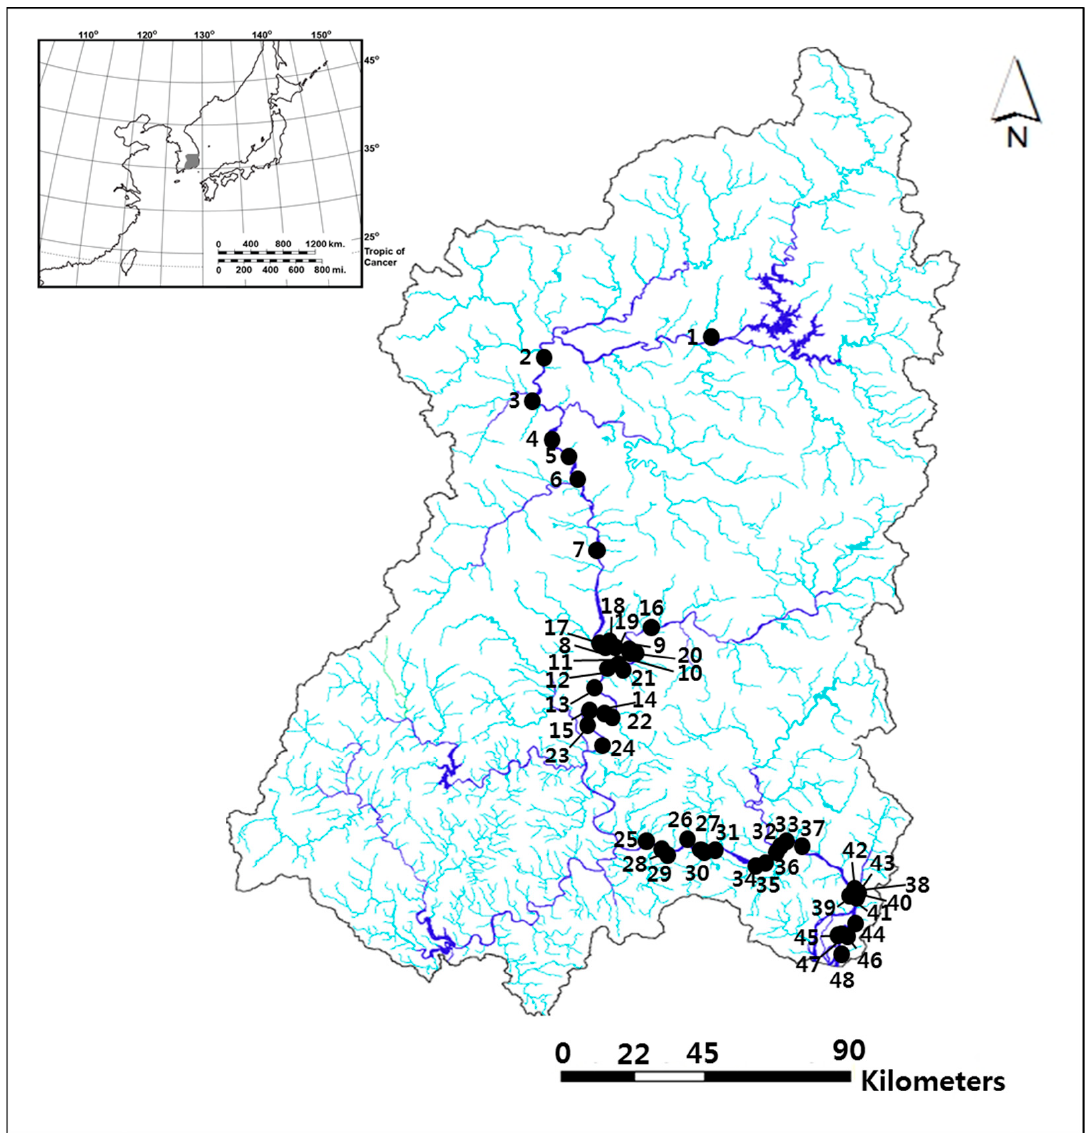
Figure 1. Map of the study area in the Nakdong River basin. The study sites are 48 created riverine wetlands and are represented by a closed circle ( ● ). The upper-left inset indicates the Korean Peninsula and study area.